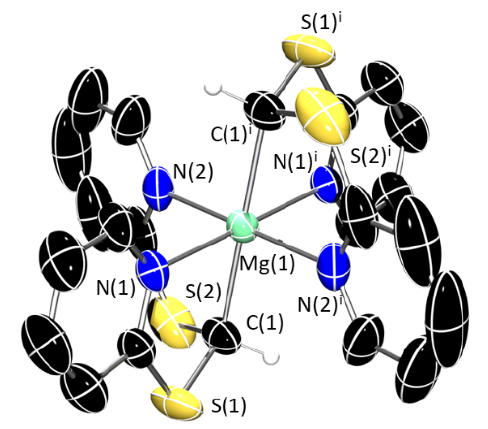
Figure 6. X-ray crystal structure of 2 . Ellipsoids are set at 50% probability level, and the benzene lattice solvent and selected hydrogen atoms have been excluded for clarity. The figure has been reproduced as a dimer to fully illustrate the geometry. Symmetry operation used to generate equivalent atoms: